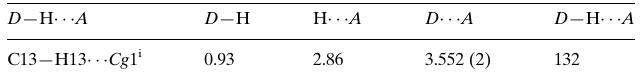
Hydrogen-bond geometry (A˚ , (cid:2) ). Cg 1 is the centroid of the C2–C7